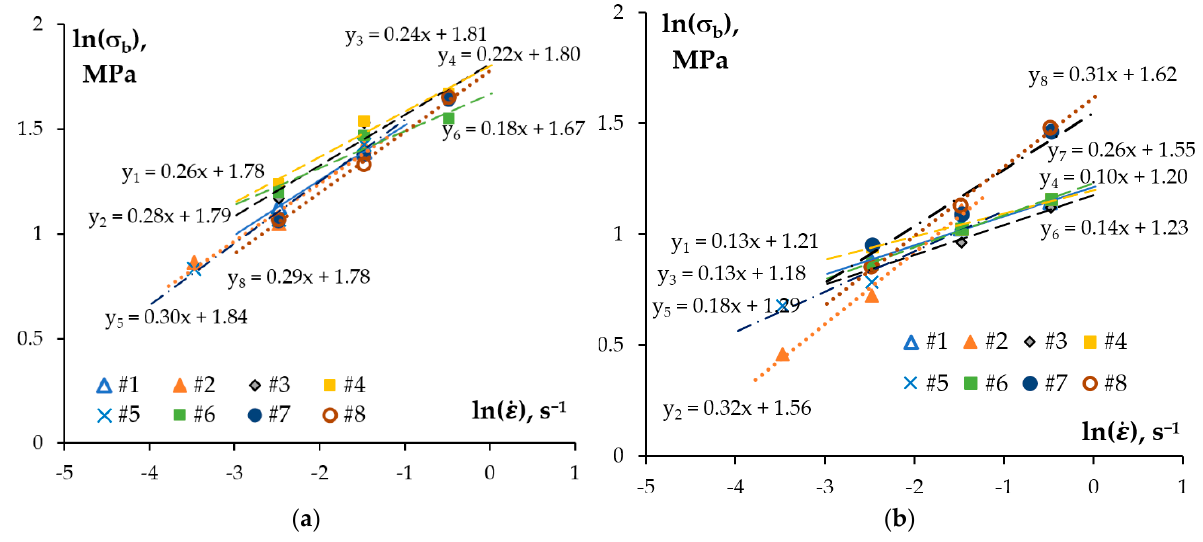
Figure 10. Dependencies of flow stress on strain rate in UFG alloys at 400 °C ( a ) and 500 °C ( b ).